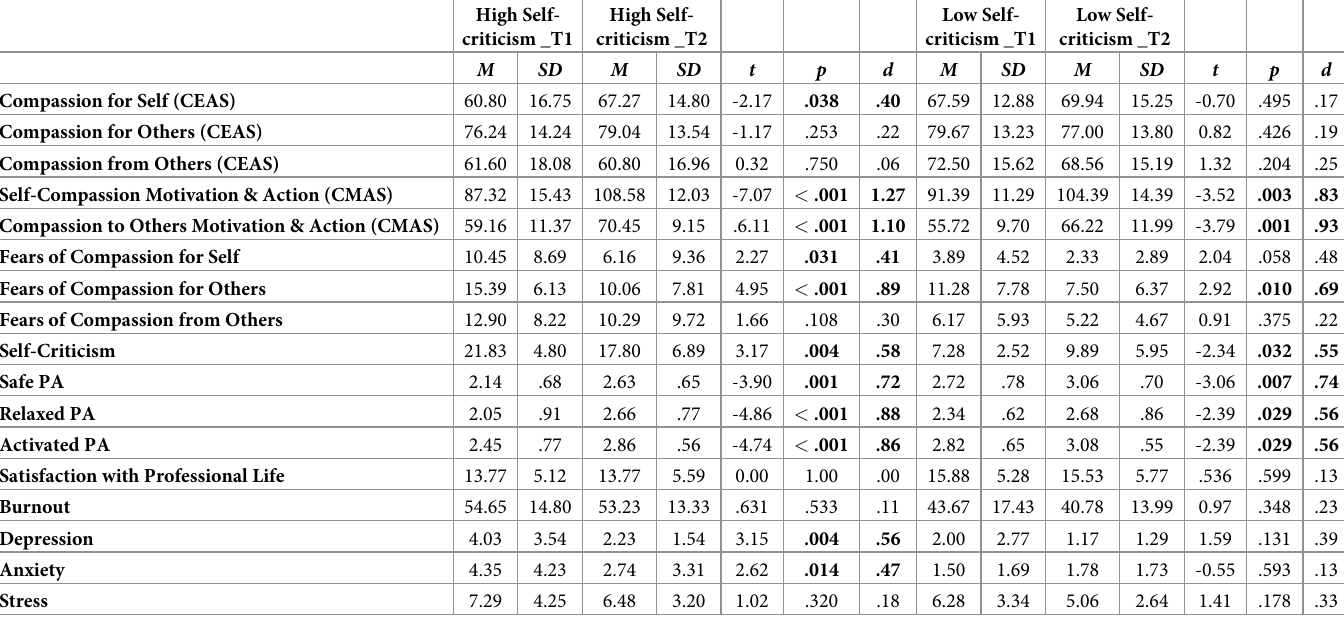
Table 5. Mean comparisons at T1 and T2 for the high self-criticism group ( N = 31) and the low self-criticism group ( N = 18) within the CMT-T